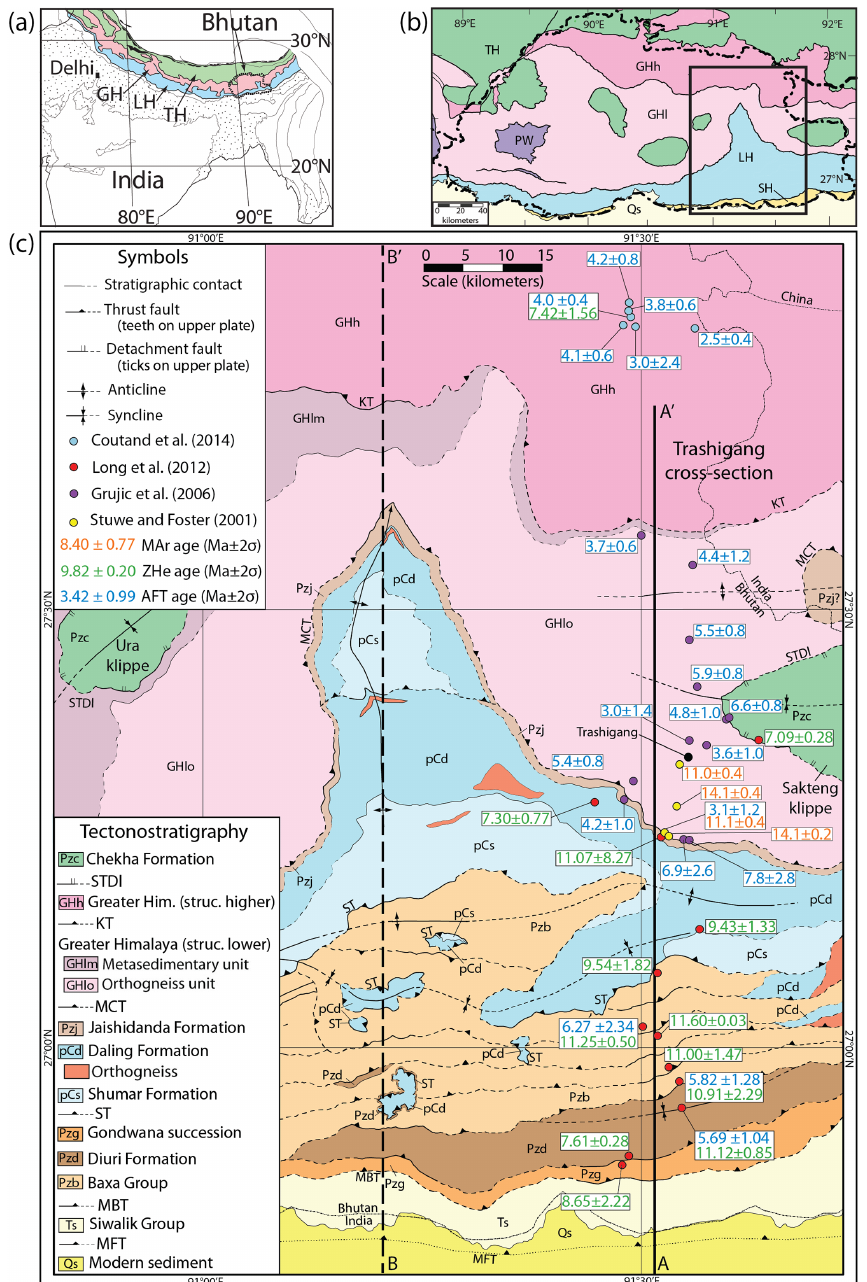
Figure 1. (a) Generalized geologic map of the central and eastern Himalayan orogen modified from Gansser (1983). Abbreviations are GH: Greater Himalaya, LH: Lesser Himalaya, TH: Tethyan Himalaya. (b) Simplified tectonostratigraphic map of Bhutan modified from Long et al. (2012). The border of Bhutan is marked as a dashed and bolded line, and the area of (c) is outlined as a solid black rectangle. Tectonostrati- graphic groups shown are TH: Tethyan Himalaya; GHh: Greater Himalaya, structurally higher; GHl: Greater Himalaya, structurally lower; PW: Paro Window; LH: Lesser Himalaya; SH: Subhimalaya; Qs: modern sediment. (c) Geologic map of eastern Bhutan with Trashigang section line A–A (cid:48) and reported thermochronometer data shown as modified from Long et al. (2012). Cooling ages are reported in millions of years. Fault abbreviations are STDI: South Tibetan Detachment; KT: Kakhtang Thrust; MCT: Main Central Thrust; ST: Shumar Thrust; MBT: Main Boundary Thrust; MFT: Main Frontal Thrust. B–B (cid:48) indicates the location of the Kuru Chu cross